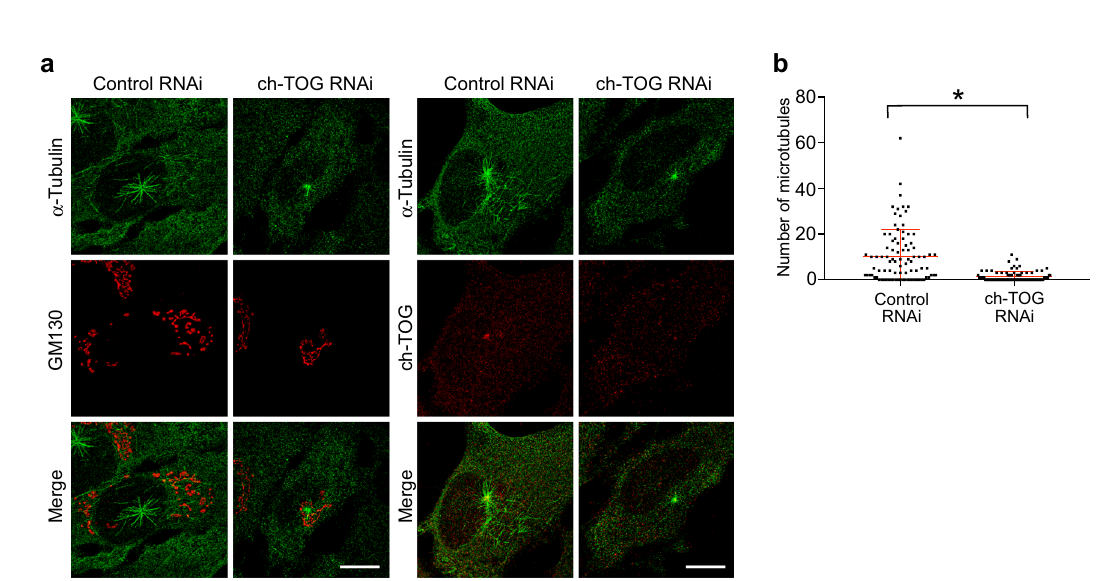
N =3 experiments, total number of cells analyzed: 90 in each condition, * p =0.0207. The horizontal bars and whiskers indicate median and interquartile range, respectively, of the plotted data points. Statistical signi fi cance was deter- mined by unpaired, two-tailed t test with Welch ’ s correction. Source data are pro- vided as a Source Data fi